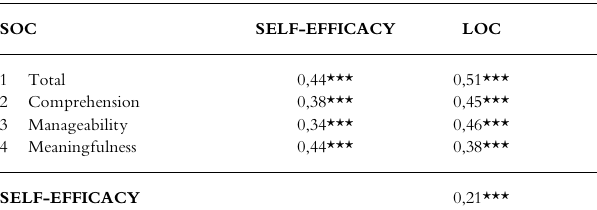
Table 2 indicates strong correlations between the three saluto- genic constructs, including the sub-scores of SOC. This cor- responds with the ¢ndings by Viviers (1996) as well as Drory and Florian (1998). TABLE 2 CORRELATIONSBETWEENSALUTOGENICCONSTRUCTS